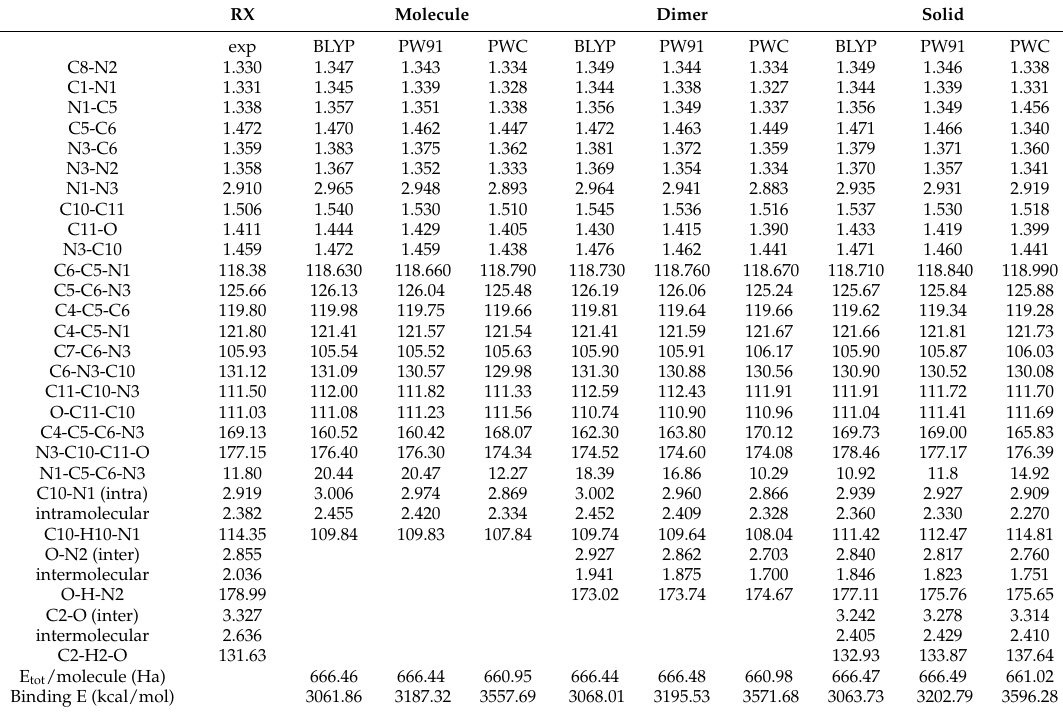
Table 2. Experimental and calculated distances (Å) and angles ( ˝ ) for molecule, dimer and crystalline structure. Calculated energies are also